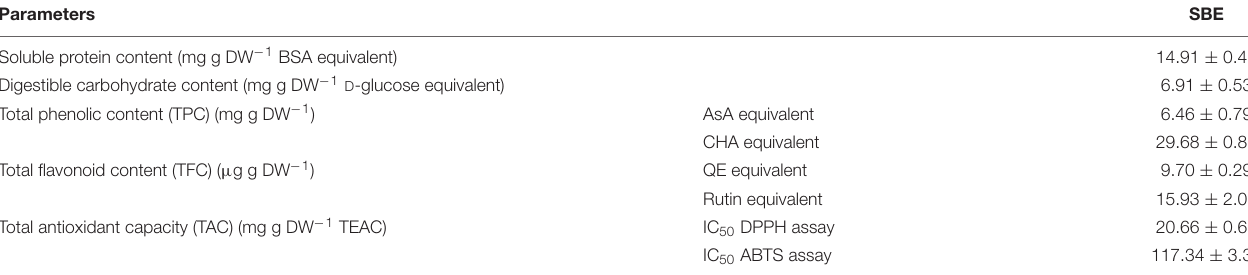
TABLE 1 | Contents of soluble protein, digestible carbohydrate, polyphenols, and in vitro antioxidant capacity in SBE. Parameters